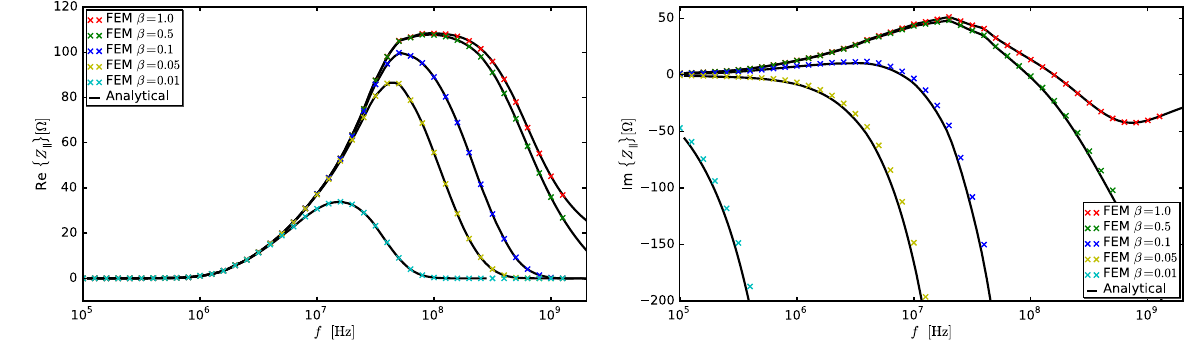
FIG. 9. Longitudinal impedance of a ferrite ring for different beam velocity.